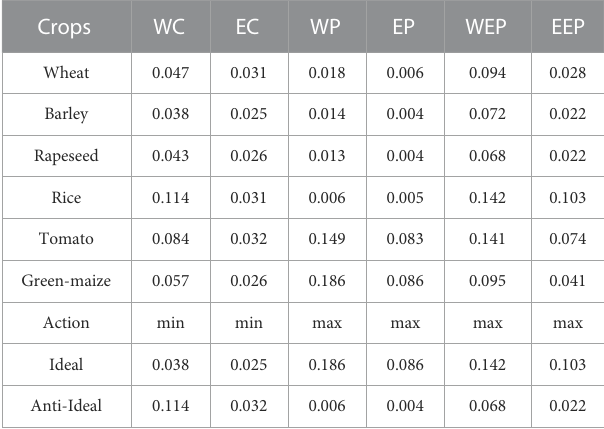
TABLE4Theweightednormalizedperformancematrixandidealandanti-ideal